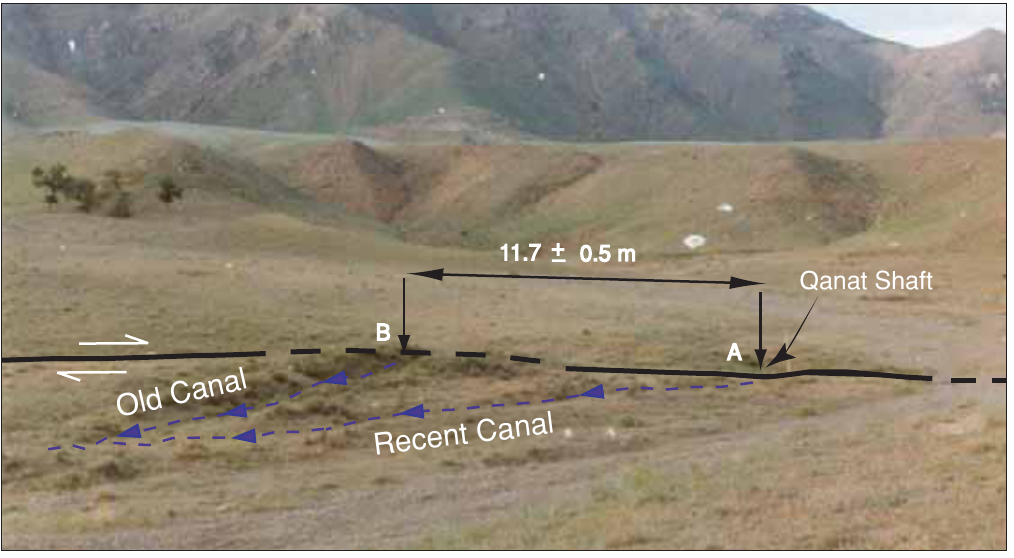
Fig. 3. Lateral offsets of the old canal across the North Tabriz Fault (looking north). The distance between old canal and its original position ( i.e. the Qanat shaft) is 11.7 m. The new canal is built where the old canal used to